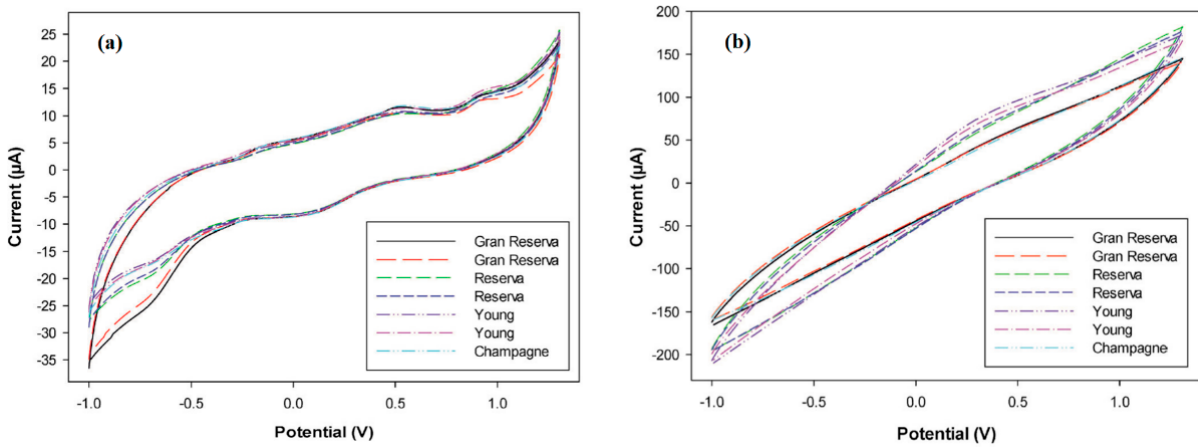
Figure 7. Cyclic voltammograms recorded with ( a ) PPy–graphite epoxy and ( b ) PANI–graphite epoxy sensors for different wine and cava samples. Adapted with permission from ref. [127]. Copyright 2014, John Wiley and Sons.